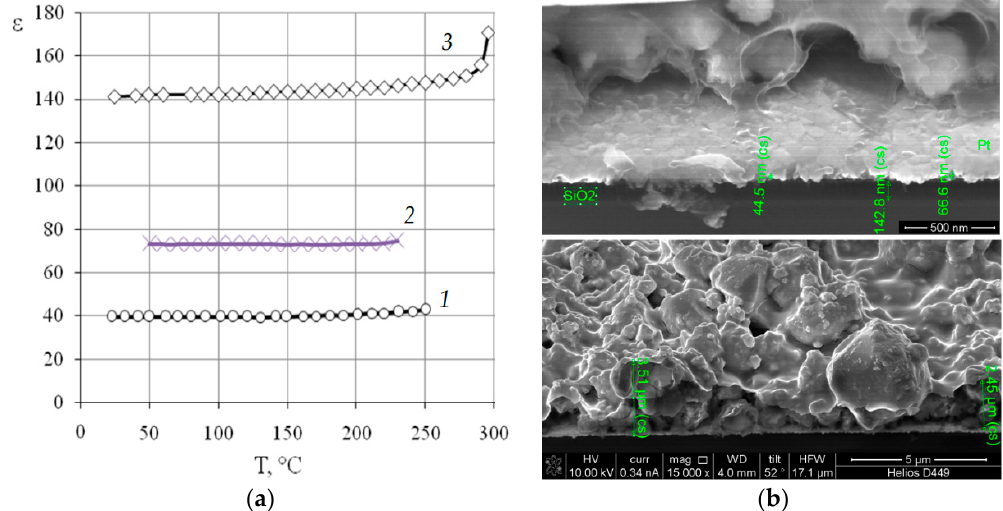
Figure 4. Temperature dependences of the dielectric constant for PZTNB-1/PBO composite films with different degrees of loading of the composite: around 30 ( 1 ), 32 ( 2 ), and 35 vol. % ( 3 ), measured at a frequency of 200 kHz at room temperature ( a ) after the heat treatment at 240 ( 2 ), 250 ( 1 ), and 300 ◦ C ( 3 ), and the SEM images of obtained composite films ( b ).